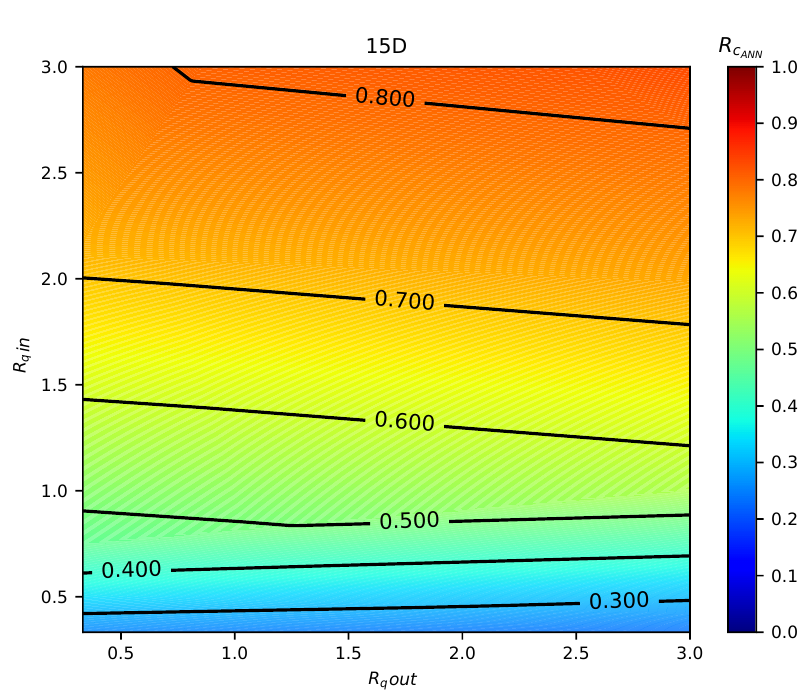
Figure 5. Predicted R c